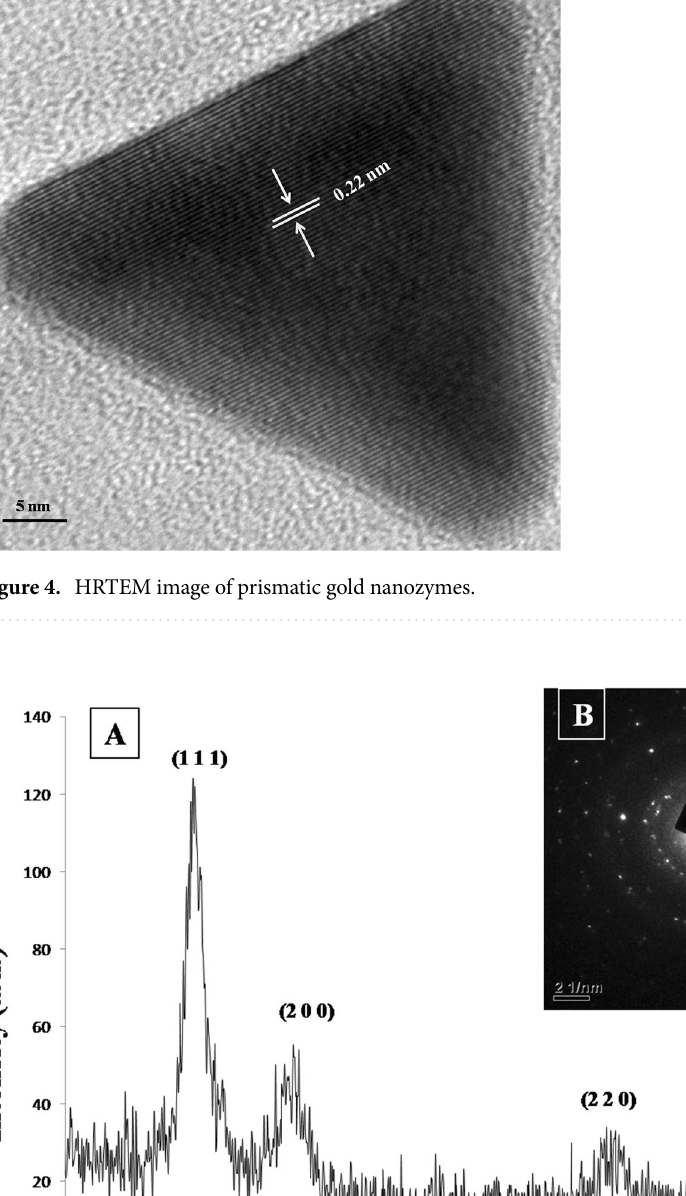
(Fig. 5B, curve 1)and that of prismatic nanozymes showed bands at 1678.07 cm −1 , 1479.62 cm −1 and 1020 cm −1 (Fig. 6B, curve 2).